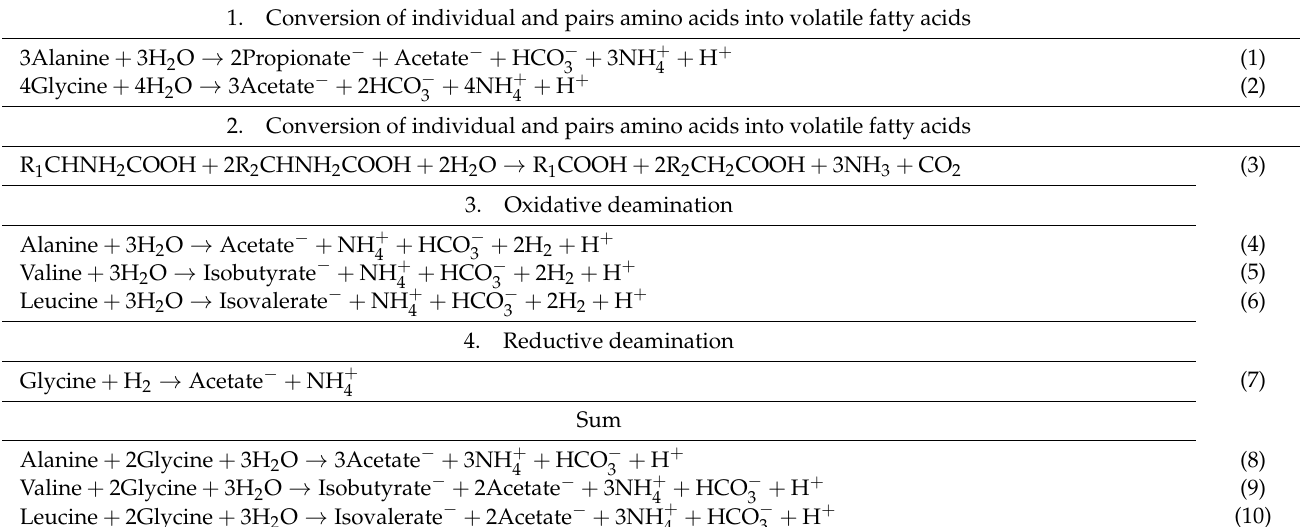
Table 1. The anaerobic conversion of individual and pairs amino acids into volatile fatty acids. 1. Conversion of individual and pairs amino acids into volatile fatty acids